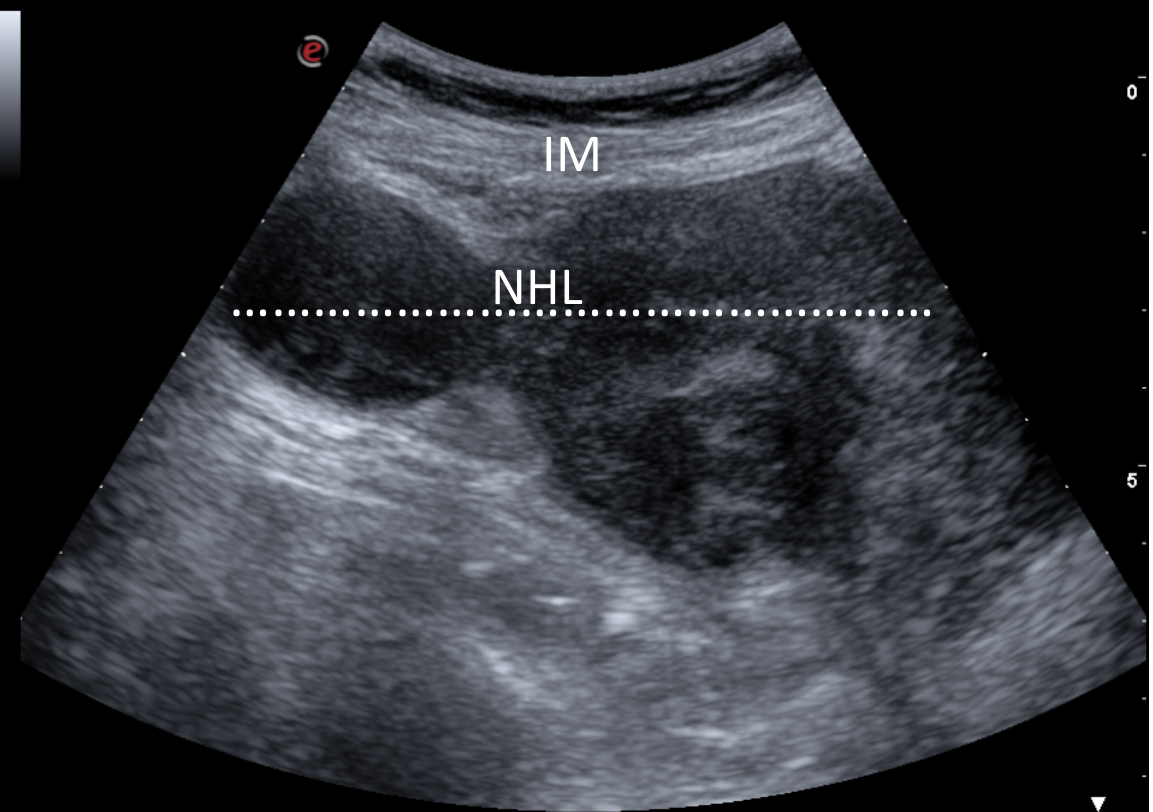
Figure 2. Detection of anterior mass by ultrasound. Ultrasound with a convex transducer placed at the level of the second intercostal space showed the presence of a large mass (70 mm size) with heterogeneous echogenicity (dotted line). The diagnosis was non-Hodgkin’s lymphoma. IM: Intercostal muscle, NHL: Non-Hodgkin’s lymphoma.